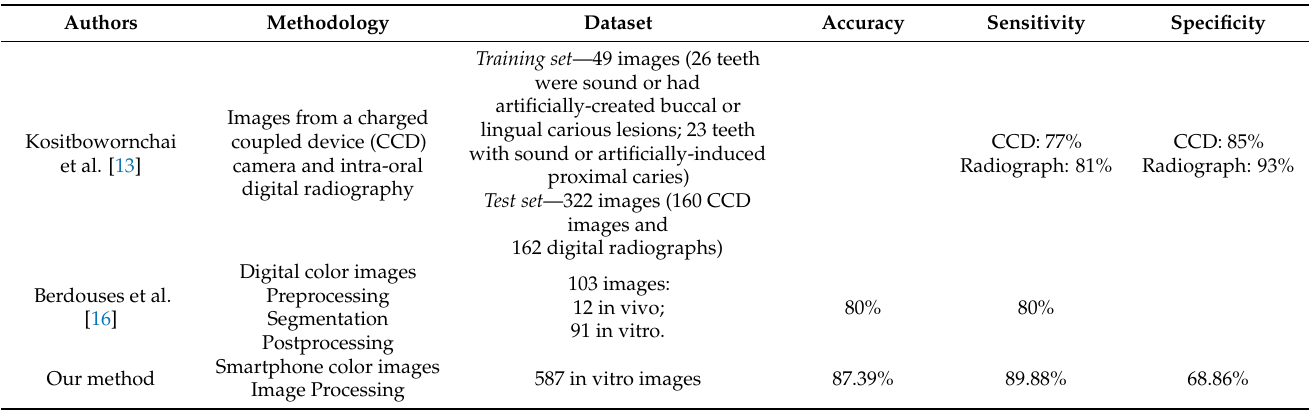
Table 6. The detection performance of the proposed method compares with other studies in the literature.